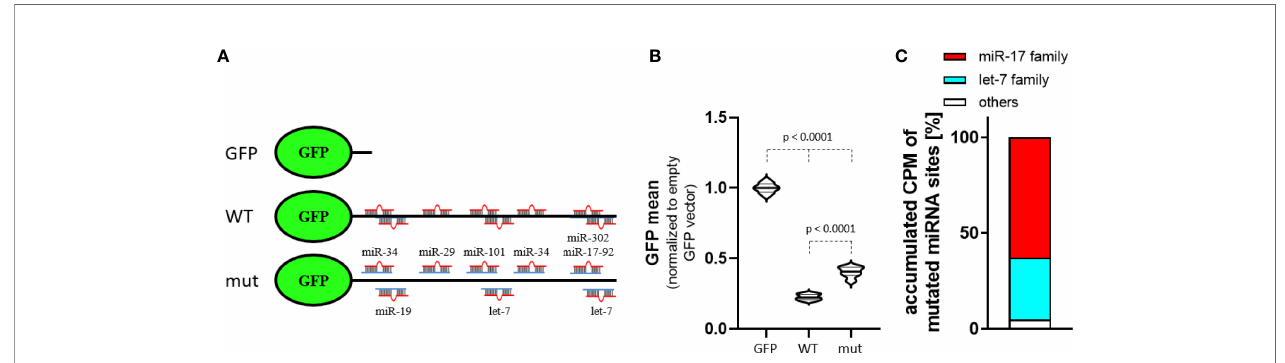
FIGURE 3 | MYCN 3´UTR is a strong miRNA target. (A) Scheme of used GFP reporters. Control reporter (GFP) contains only a minimal, vector-encoded 3´UTR. MYCN wildtype (WT) and mutated (mut) 3´UTR were inserted 3 ’ of the GFP open reading frame. The mutated 3´UTR was generated by conversion of seed sequences in eight indicated miRNA-targeting sites. (B) Normalized mean GFP fl uorescence in BE(2)-C cells transiently transfected with GFP reporters. The WT MYCN-3´UTR is strongly repressed, indicated by lower GFP fl uorescence. Mutation of several miRNA-binding sites increases GFP fl uorescence (n = 3). (C) Among the accumulated CPM (count per million) of mutated MYCN-regulatory miRNA sites in BE(2)-C the miR-17 seed family (red) and let-7 family (cyan) are the most abundant. Statistical signi fi cance was determined by Student ’ s t-test (p-values indicated).